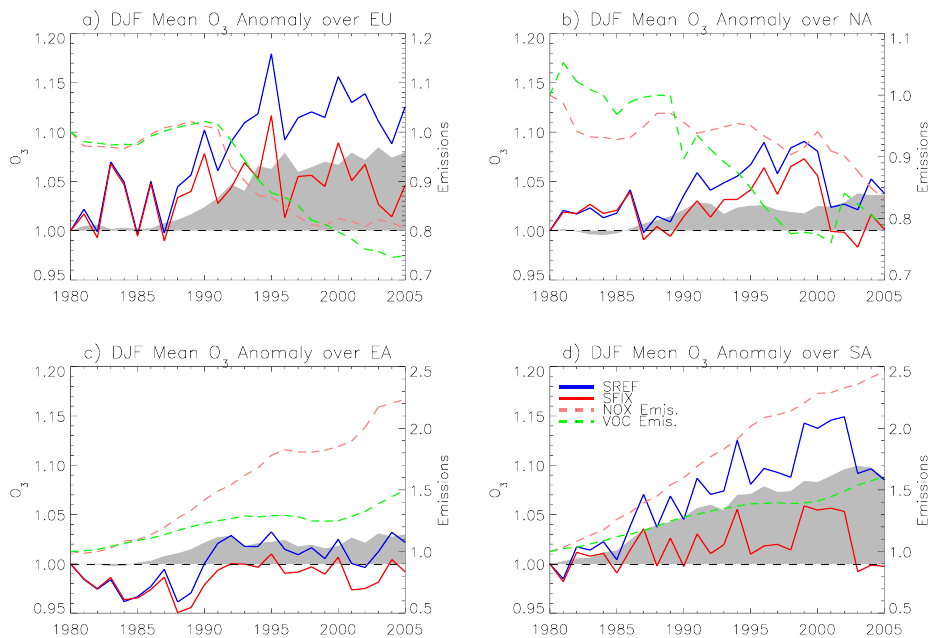
Fig. 7. Winter (DJF) anomalies of surface O 3 concentrations averaged over the selected regions (shown in Fig. 1). On the left y-axis anomalies of O 3 surface concentrations for the period 1980–2005 are expressed as the ratios between seasonal means for each year and the year 1980. The blue line represents the SREF simulation (changing meteorology and changing anthropogenic emissions), the red line the SFIX simulation (changing meteorology and fixed anthropogenic emissions at the level of 1980), while the gray area indicates the SREF- SFIX difference. On the right y-axis the green and pink dashed lines represent the changes, i.e. the ratio between each year and 1980, of total annual VOC and NO x emissions, respectively.